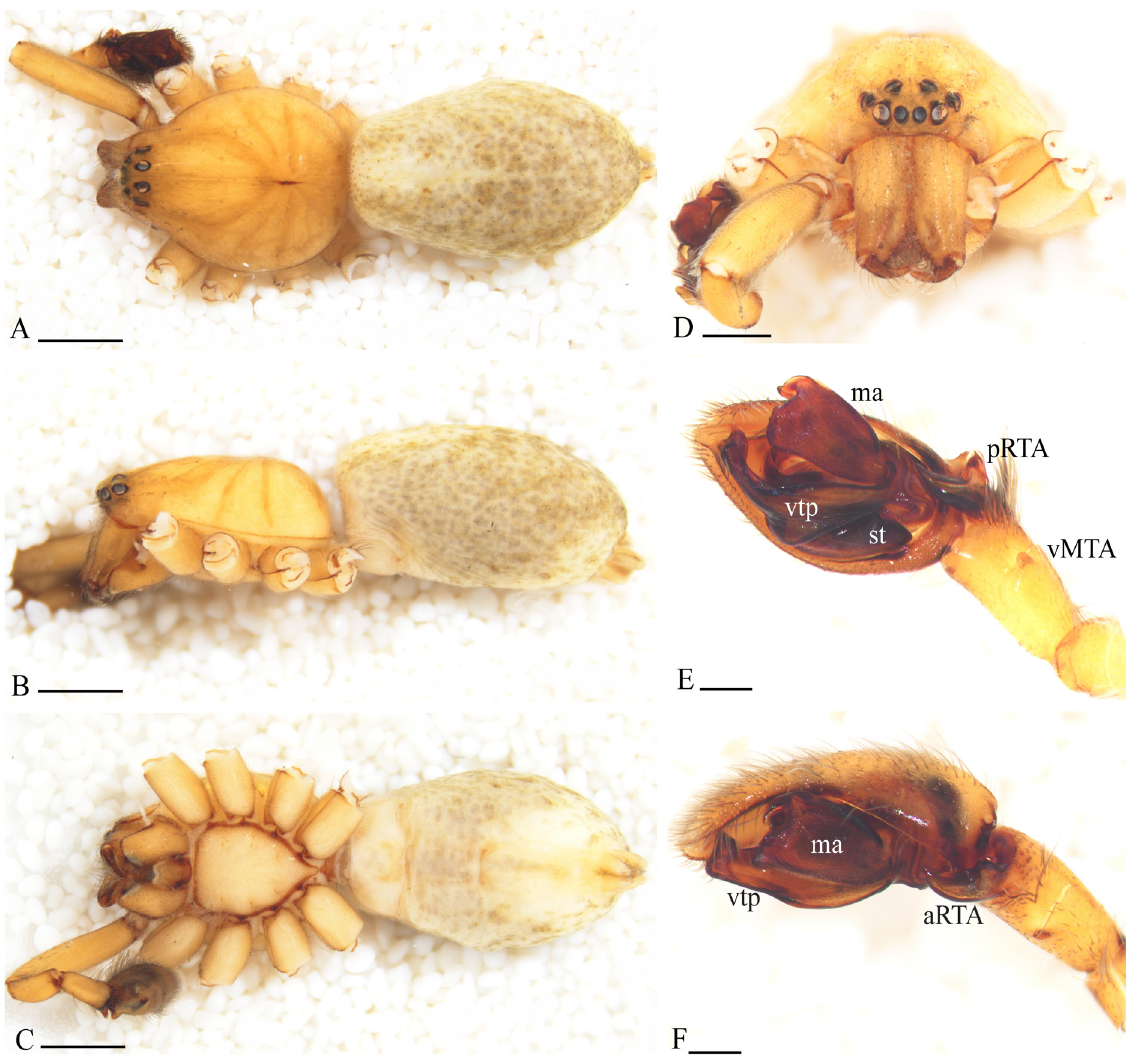
Fig. 48. Anyphaena megamedia sp. nov., paratype, ♂ (CNAN-T01558). A . Dorsal habitus. B . Lateral habitus. C . Ventral habitus. D . Prosoma, anterior view. E . Pedipalp, ventral view. F . Pedipalp, retrolateral view. Scale bars: A–C = 1.0 mm; D = 0.5 mm; E–F = 0.2